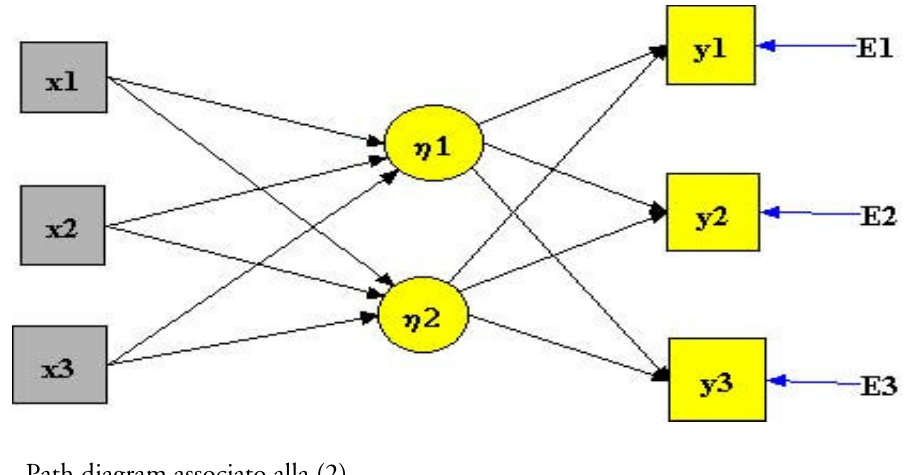
Figura 3 – Path diagram associato alla